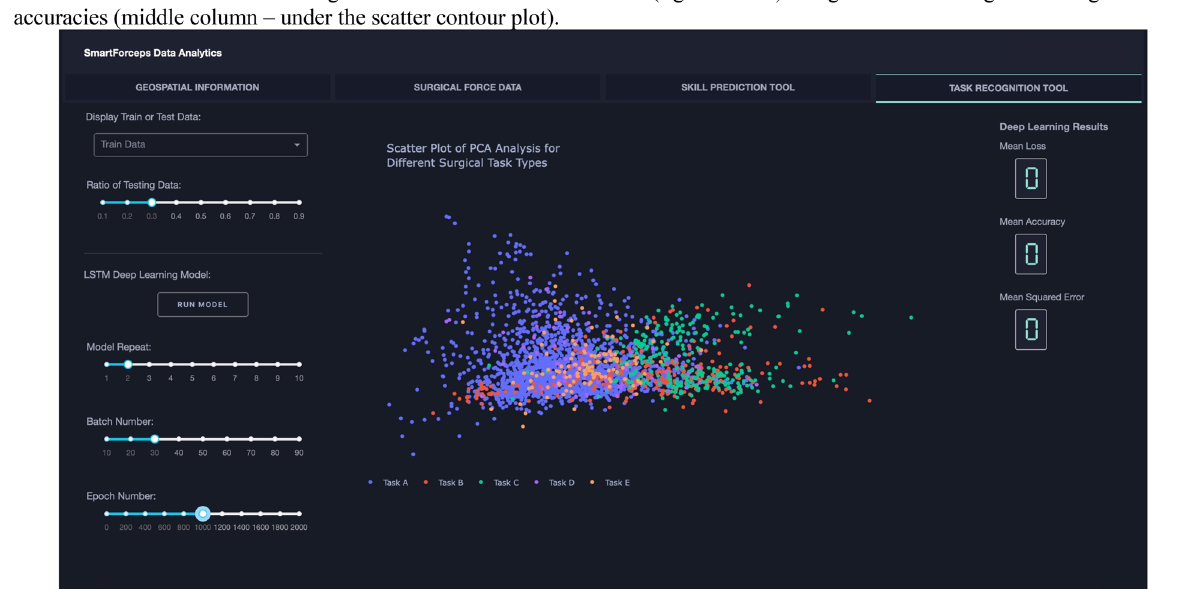
Figure 5. SmartForceps Data Analytics Dashboard in "Data Scientist" view. The current view includes four tabs of "Geospatial Information", “Surgical Force Data”, “Skill Prediction Tool” ( a ), and “Task Recognition Tool” ( b ). The figure for dashboard was created by Python Dash library version 0.43.0: https:// plotly. com/